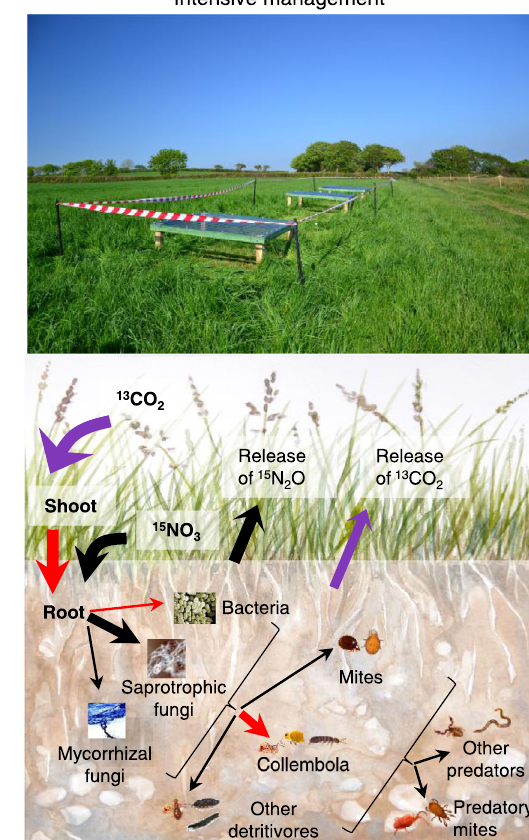
N 2 O ef fl ux. The size of the arrows corresponds to the relative proportion of 13 C or 15 Nincorporatedbytheplant,soilorganismsandreleasedassoilef fl ux.Picturesby M. Chomel, grassland illustration by J. C. Bardgett. Note that we present only the main effects, so every arrow (except the N 2 O ef fl ux) concerns 13 C transfer. The transfer of 15 N to soil organisms was not impacted by